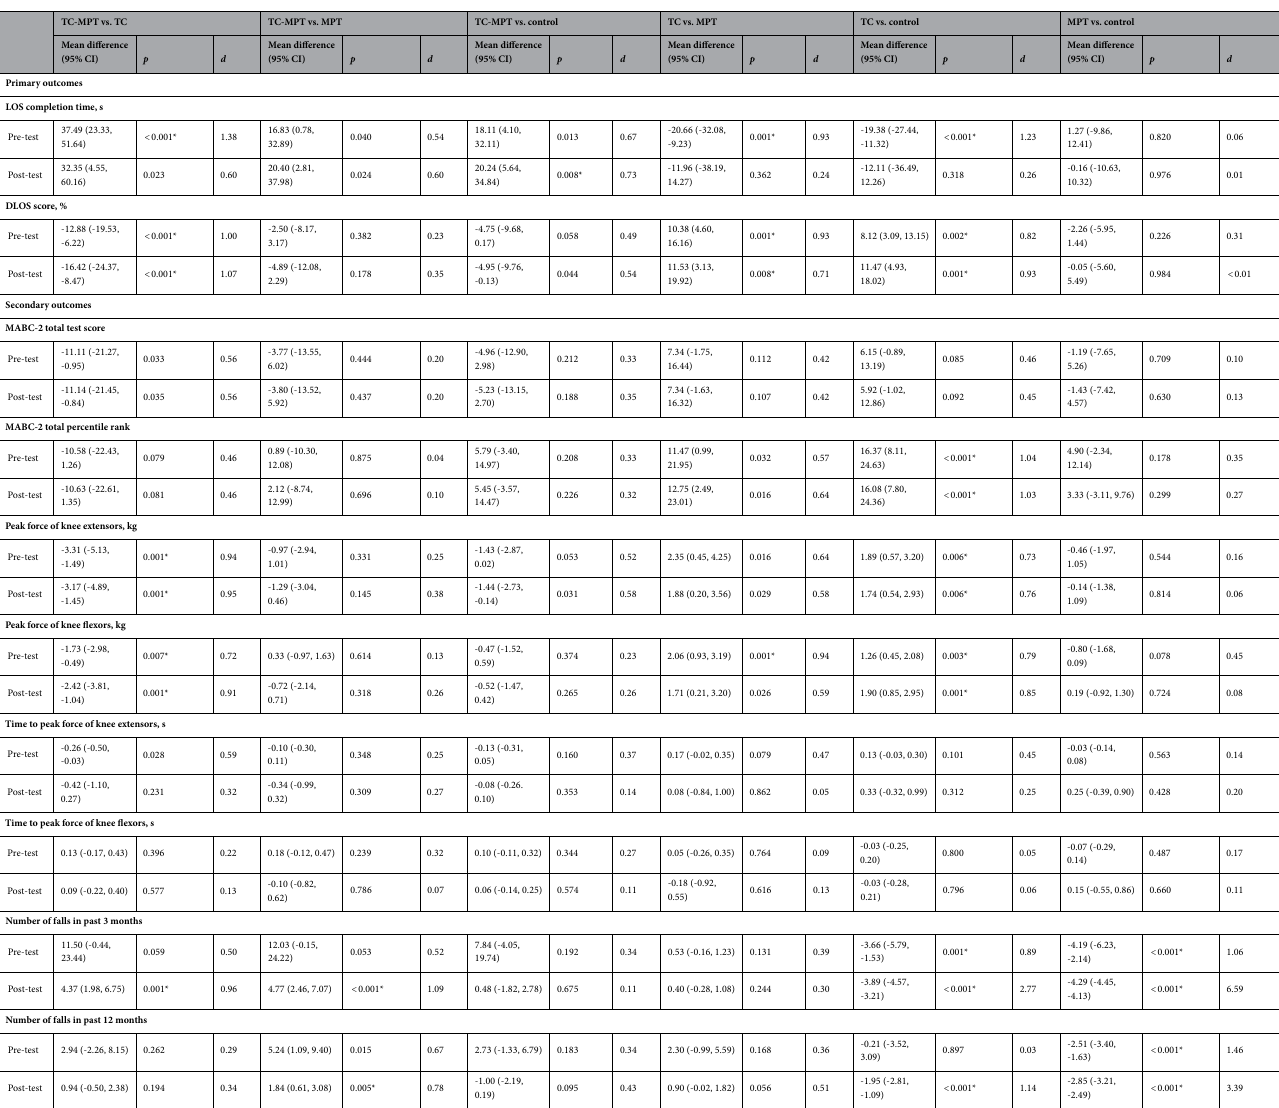
Table 3. Between-group comparisons of the primary and secondary outcomes. TC = tai chi, MPT = muscle power training, CI = confidence interval, d = Cohen’s d, LOS = limits of stability, DLOS = dynamic limits of stability, MABC-2 = Movement Assessment Battery for Children–Second Edition. * p < 0.0083 (Bonferroni-